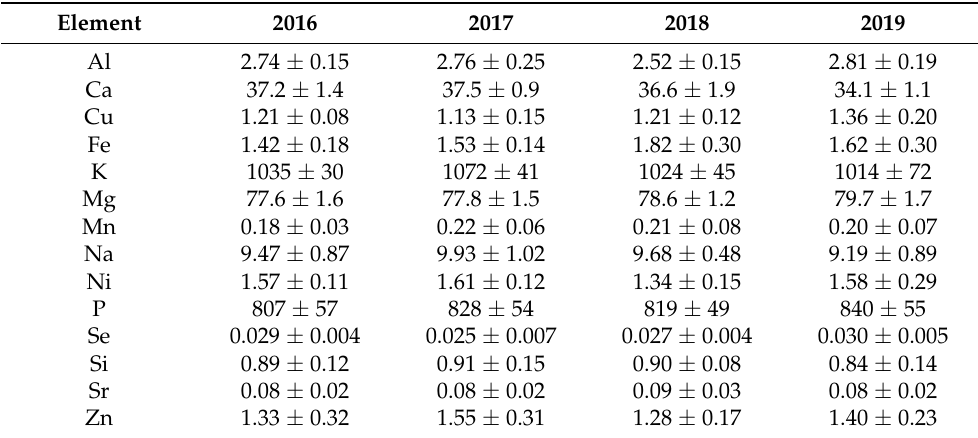
Table 5. Concentrations of some elements (mg/100 g, on dry matter basis) * in horse chestnut flour from AHH semen, harvested in different